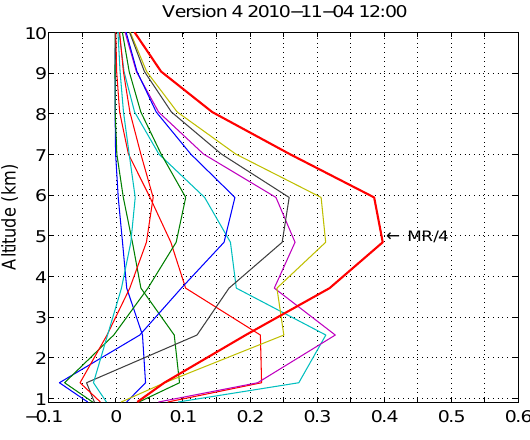
Fig. 6. Averaging kernels for the 4 November 2010 12:00 (opac- ity=0.141, using 2h averaged spectra). The bold red line indicates the sum of AVK rows (“measurement response”) divided by 4.